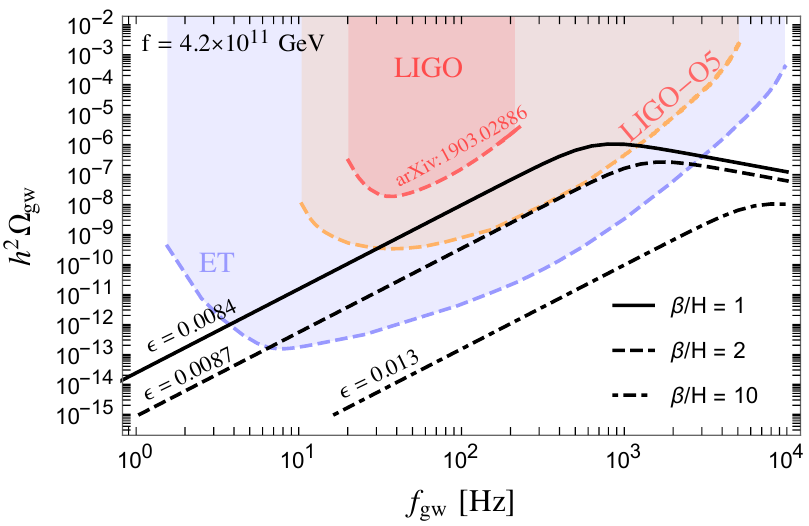
Figure 7 . Gravitational wave signal for strongly coupled conformal axions. The main di(cid:11)erence compared to weakly coupled models (see (cid:12)gure 4) is the shift of the gravity wave peak to higher frequencies due to the larger dilaton decay